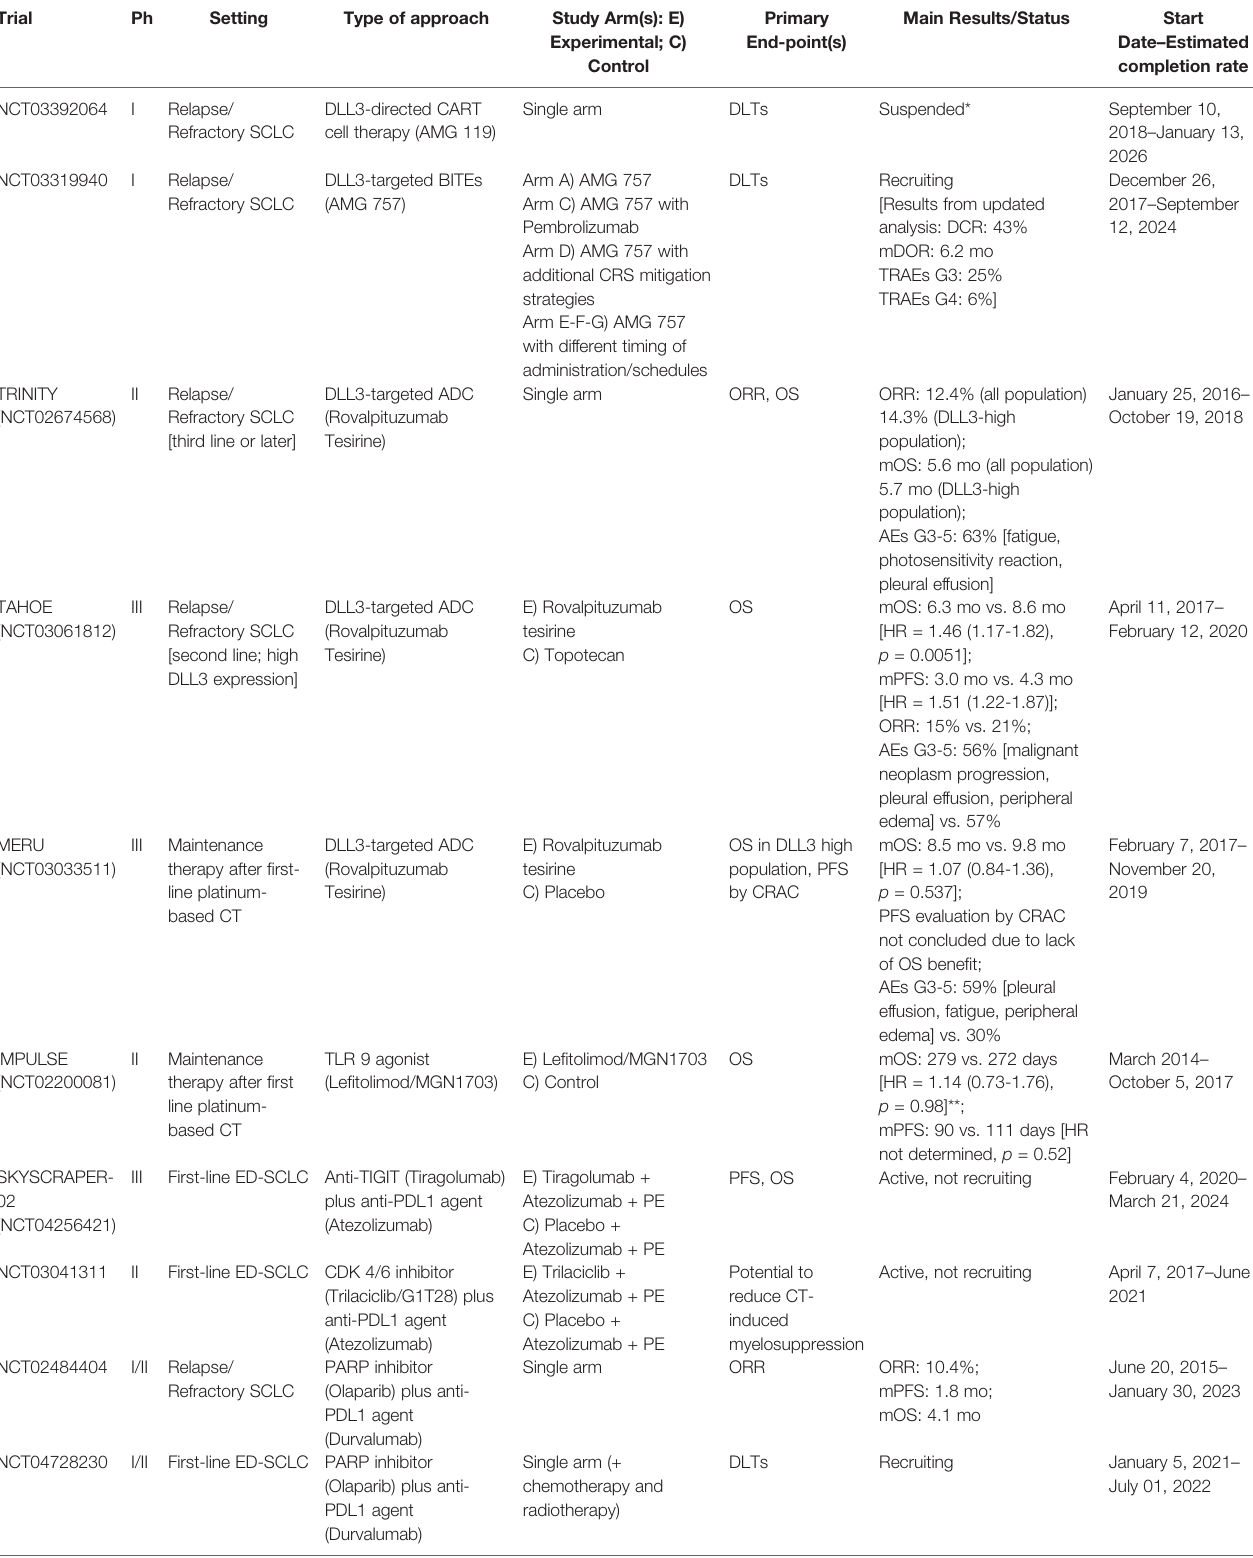
TABLE 3 | Selected clinical studies including novel drugs/novel combinations in SCLC.